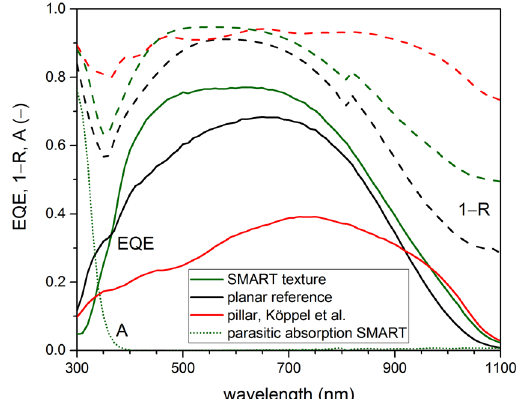
Figure 4. Optoelectronic characterization of solar cells with a SMART texture (green), planar reference (black) and nano-pillar array from ref. 11 (red), as measured by external quantum efficiency (EQE, solid) and 1-reflectance (1 − R , dashed). The dotted curve shows the parasitic absorption in the SMART texture ( A , dotted).